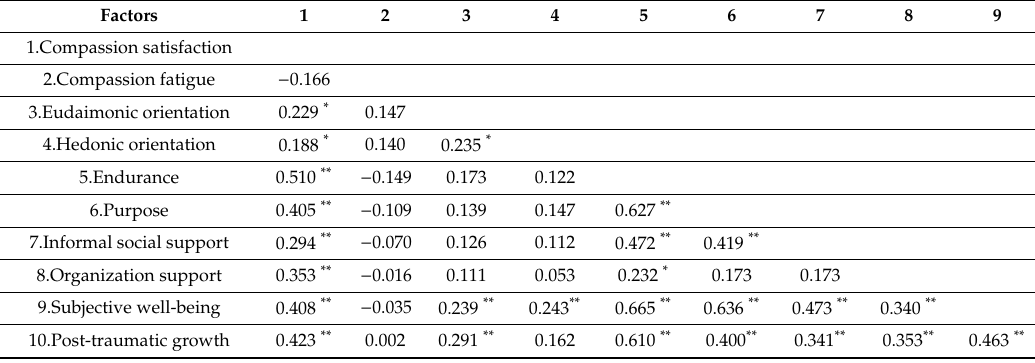
Table 1. Zero-order correlations between the factors analyzed.